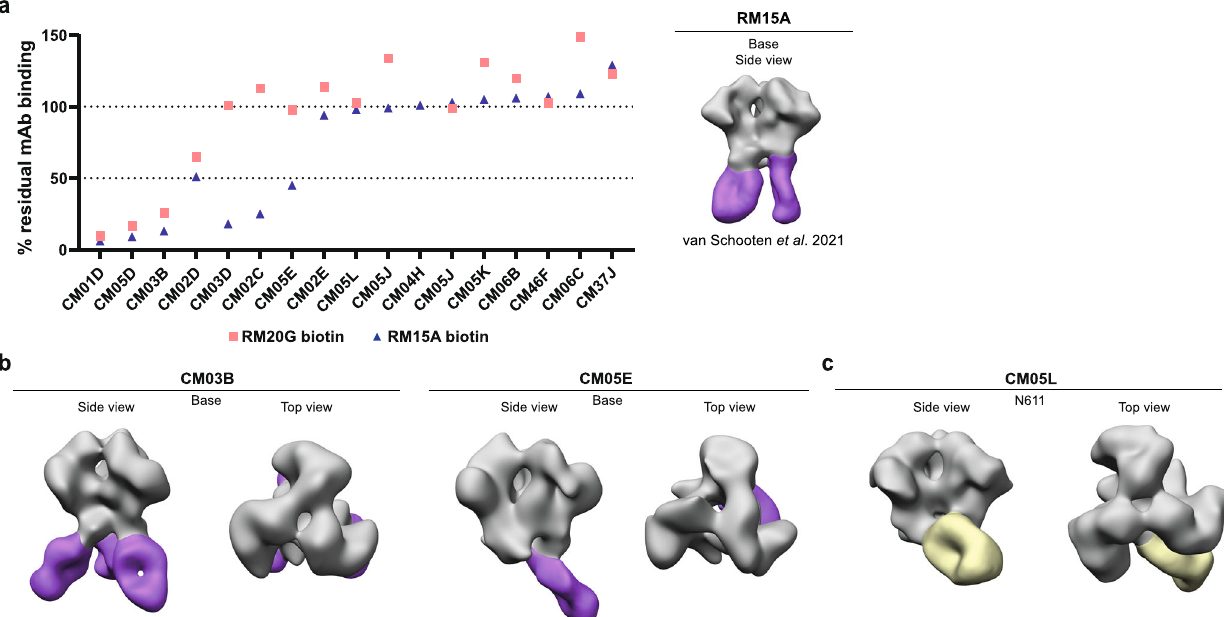
Fig. 5 Epitope speci fi cation of non-V1V2 region targeting non-NAbs. a Percentage of residual binding of suspected non-V1V2 targeting non-NAbs to ConM SOSIP.v7 trimers in presence of a competing biotinylated base binding mAb (RM15A, RM20G). Base binders were classi fi ed as mAbs that showed competition (<60% residual binding) with either of the two competitor base binding mAbs. b , c Negative stain-electron microscopy (NS-EM) was performed on a selection of mAbs to verify various epitope speci fi cities. NS-EM con fi rmed the binding of CM03B and CM05E to the trimer base and CM04F and CM05L to the N611-glycan region. mAbs are complexed with ConM SOSIP.v9.0